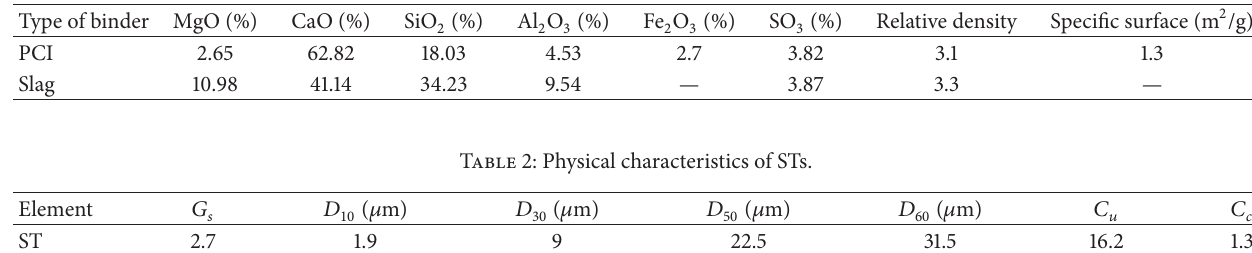
Table 1: Characteristics of the binders (PCI and Slag).